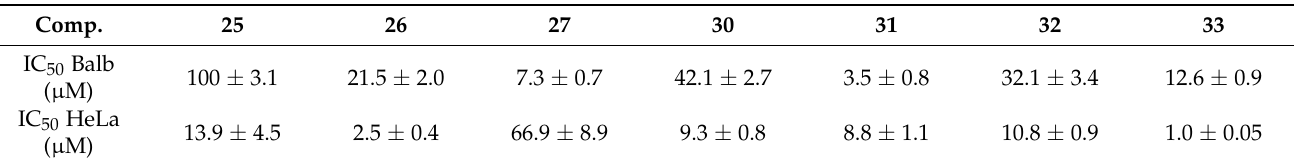
Table 4. IC 50 ( µ M) values of the series 2 and 3 of isatin derivatives in murine fibroblast 3T3 and human cervical cancer